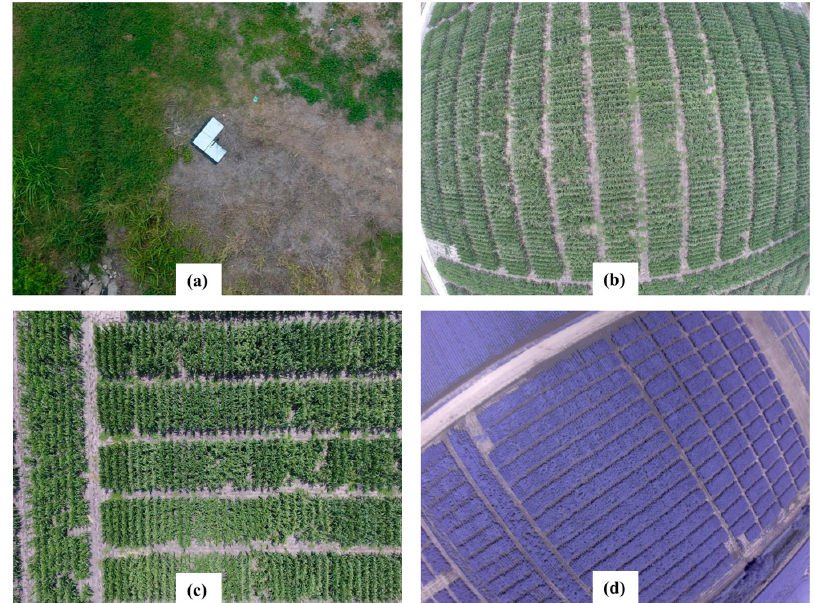
Figure 2. Sample images of the field trial: ( a ) Sample image containing a permanent ground control target (GCT); ( b ) Sample image taken by the GoPro HERO3+ camera on the 3DR Solo quadcopter platform; ( c ) Sample image taken by the DJI FC330 camera on the DJI Phantom 4 quadcopter platform; ( d ) Sample image taken by the Canon PowerShot S110 NIR camera on the senseFly eBee fixed-wing platform.